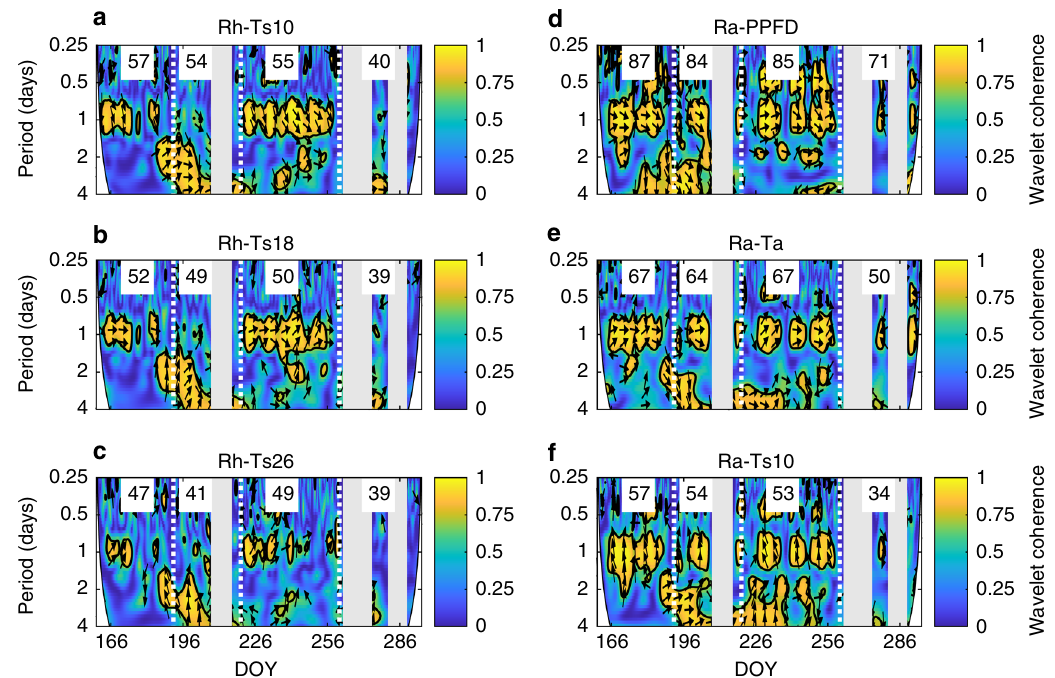
Fig. 5 Abiotic controls of heterotrophic and autotrophic respiration. Wavelet coherence (yellow = strong and blue = absent) between hourly fl uxes of a – c heterotrophic respiration (Rh) and d – f autotrophic respiration (Ra) and their abiotic controls (i.e., soil temperature at 10, 18, and 26 cm depth (Ts10, Ts18, and Ts26), photosynthetic photon fl ux density (PPFD) and air temperature (Ta)) in 2015 (see similar results for 2016 in Supplementary Fig. 7; no Rh and Ra data were available in 2017). Arrows indicate lag: right = no lag, up or down = quarter diel cycle (i.e., 6 h) lag of the fl ux behind or ahead of environmental variable, respectively, left = antiphase lag (i.e., 12 h). Gray vertical bands indicate extended periods with missing hourly Rh and Ra data. Vertical dotted lines indicate transitions between the phenophases (green-up → peak season → senescence → autumn dormancy). Numbers in white boxes represent the Welch ’ s cross power spectral density values between the hourly fl ux and environmental variables at the 1-day period (see also Supplementary Fig. 9). DOY stands for day of